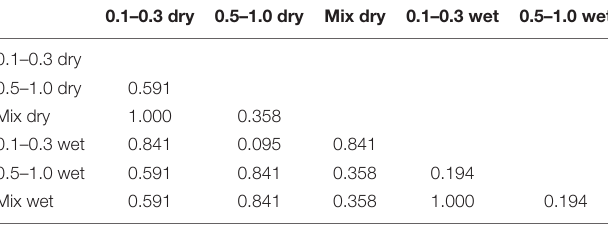
TABLE 1 | Two sample Kolmogorov-Smirnov test to assess for significant differences between the distribution of injury risk